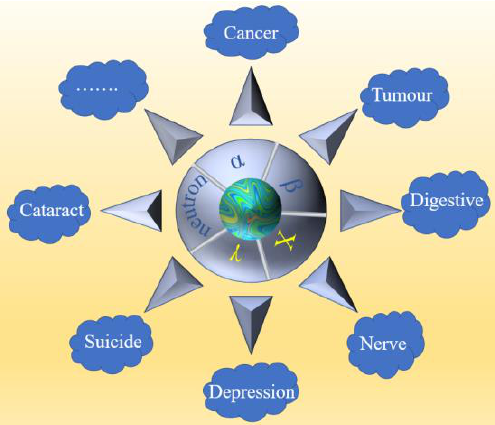
Figure 5. Sources of radiation pollution and their potential health hazards.